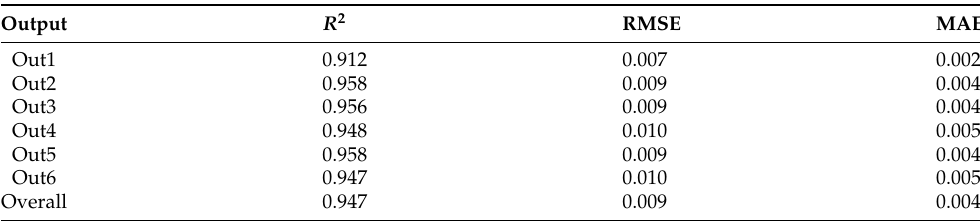
Table 4. Evaluating the performance of the trained surrogate model using six outputs: Out1 through Out6.